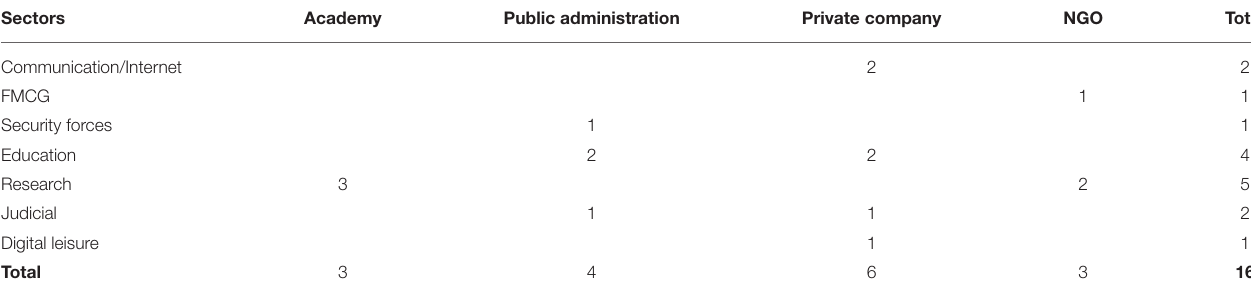
TABLE 1 | Sample of experts by sector.